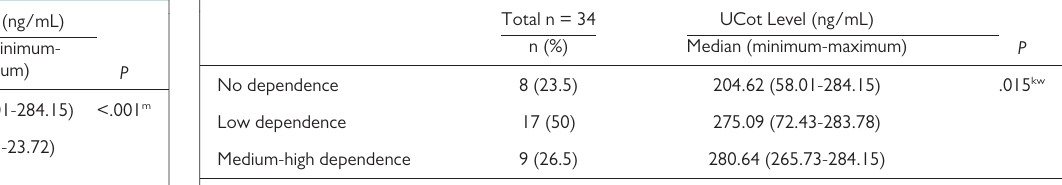
Table 3. UCot Level of Subjects